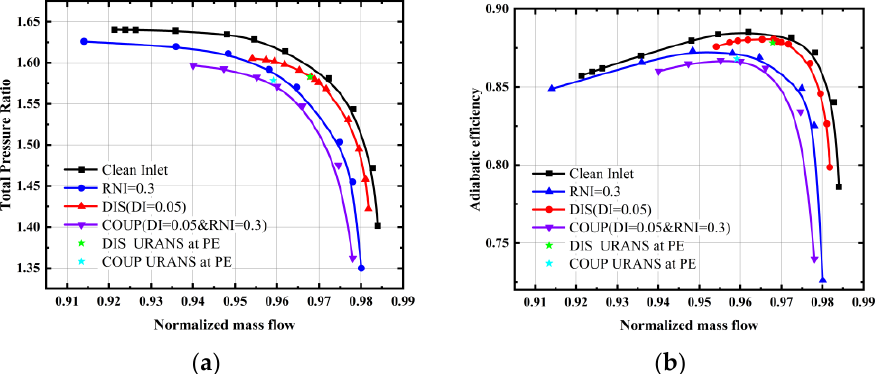
Figure 8. Comparison of fan stage performances under different conditions. ( a ) Total pressure ratio characteristics; ( b ) adiabatic efficiency characteristics.